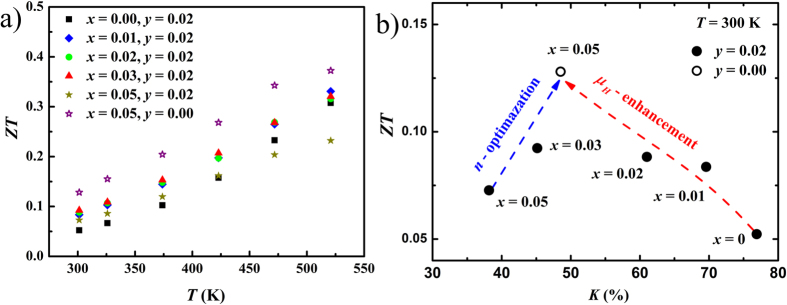
(a) Temperature and (b) compensation ratio dependent figure of merit ZT for all CuxBiTe1−yI1+y samples.